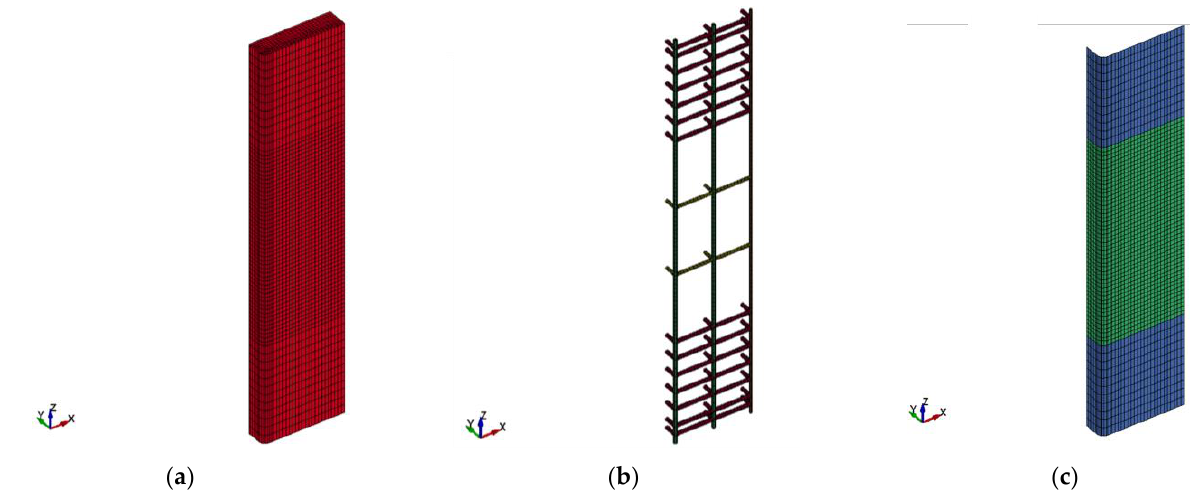
Figure 16. FE mesh for strengthened specimen SW1: ( a ) concrete volume; ( b ) reinforcement cage; and ( c ) CFRP sheets.